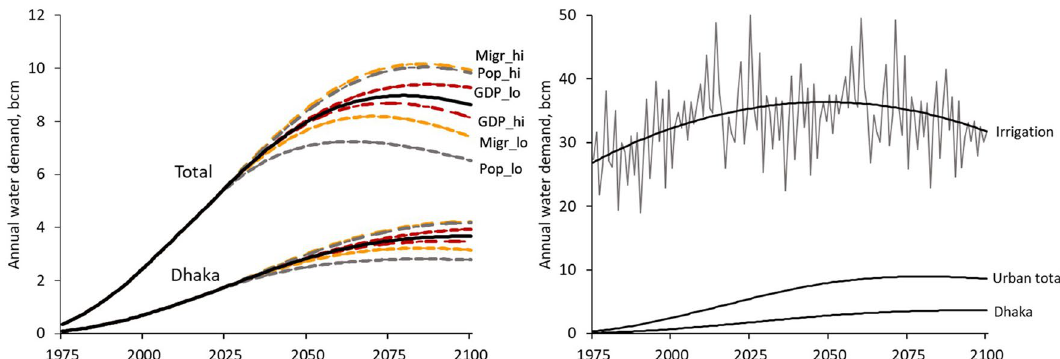
Figure 6. Volume of water demand for urban areas, total and Dhaka only, under a range of scenarios (left hand plot). The black lines are the base case (business as usual). The scenarios (dotted, colour lines) are labelled in the case of the total urban demand; the Dhaka scenarios have the same line colour and format, and occur in the same position relative to the base case. The volume of water demand in the base case for urban (total and Dhaka only) is compared with the base case Bangladesh total irrigation demand (right hand plot). For irrigation, the projected actual demand is shown as the thin grey line, with the fitted polynomial shown as the black